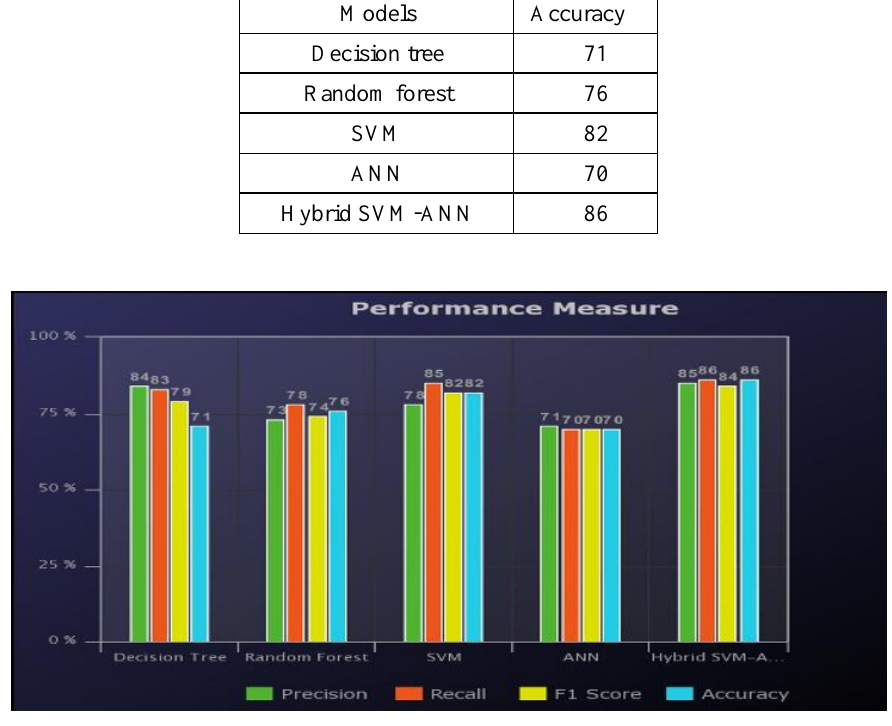
Figure 5. Diagrammatic representation of hybrid